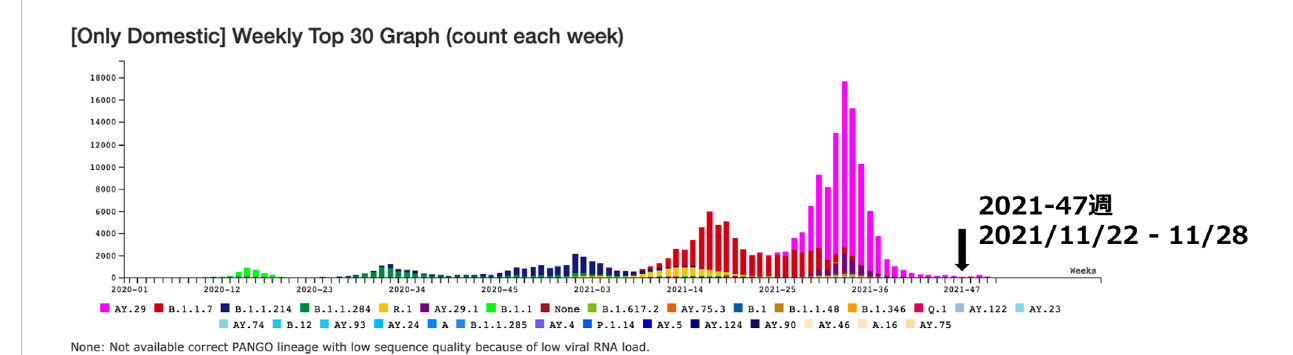
FIGURE 6 COVID-19 variants in Japan